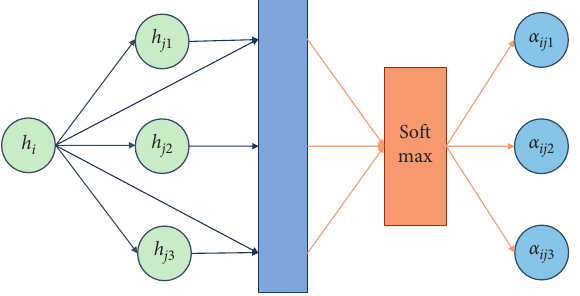
Figure 5: Graph attention mechanism.